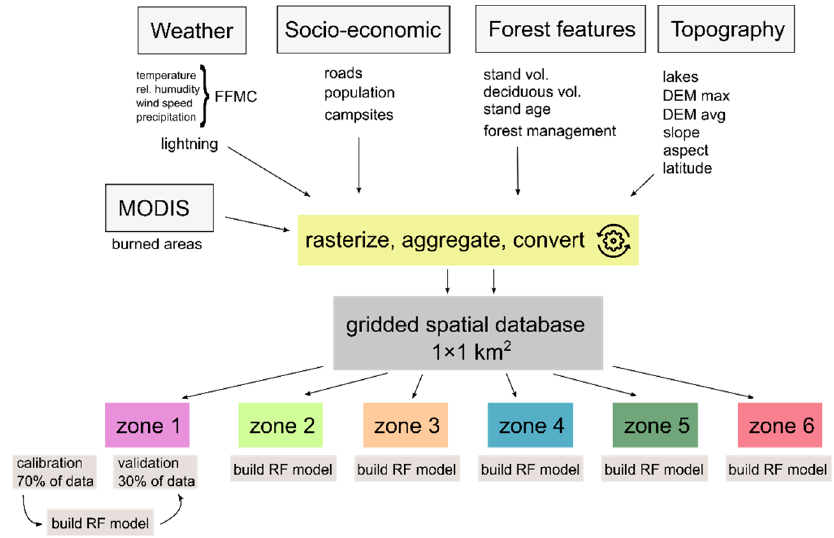
Figure 2. Data processing workflow.